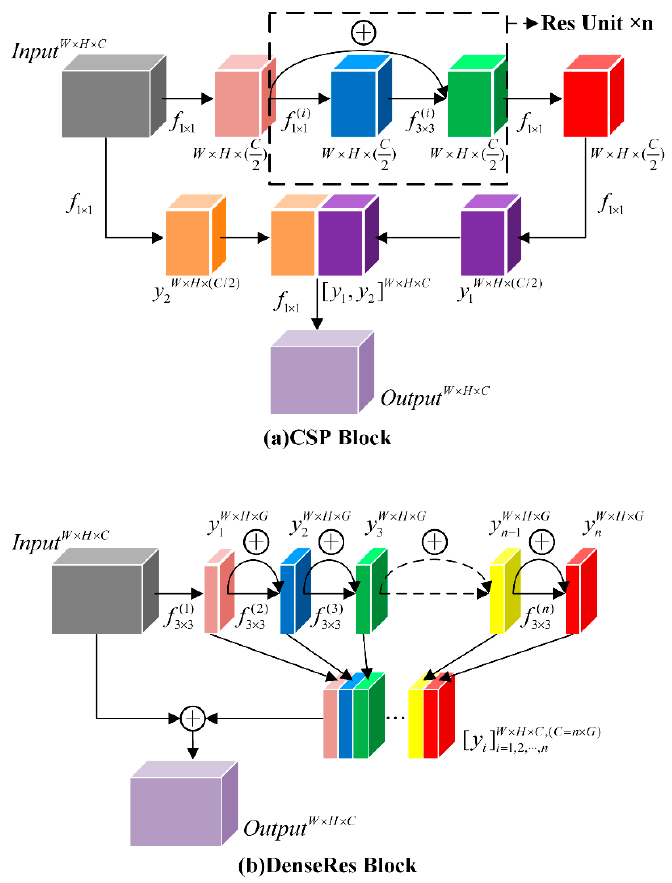
Figure 4. The structure comparison between CSP Block ( a ) and DenseRes Block ( b ).